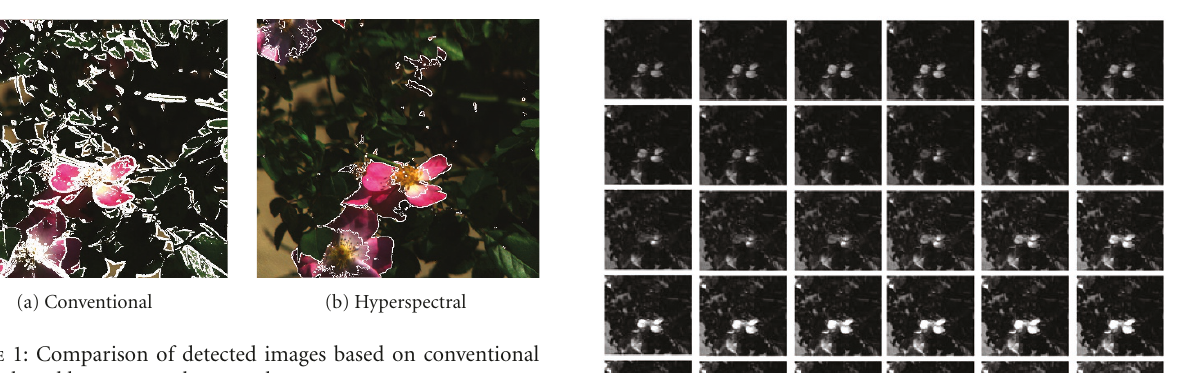
Figure 1: Comparison of detected images based on conventional approach and hyperspectral approach.